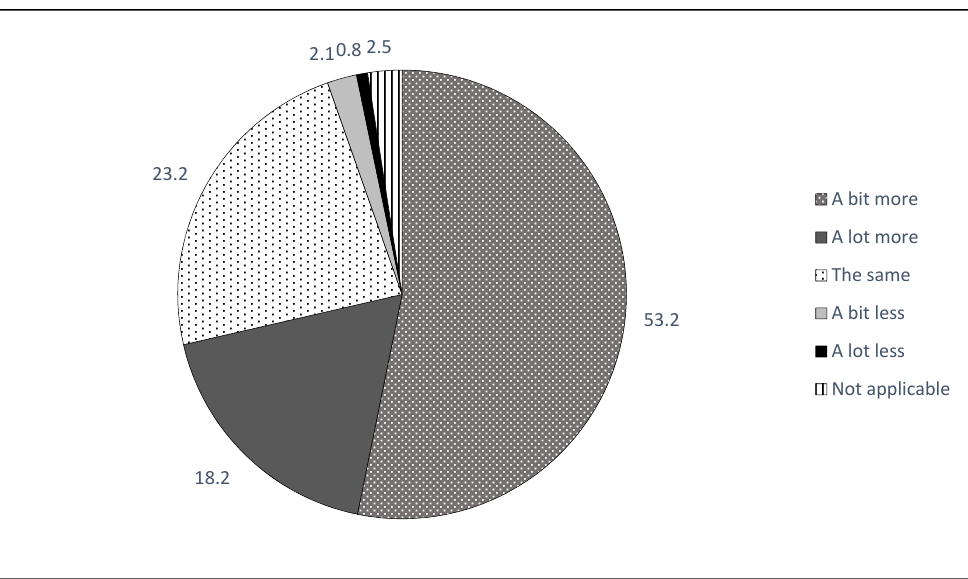
Figure 1. Descriptive self-reported change in online media consumption during the COVID-19 lockdown.